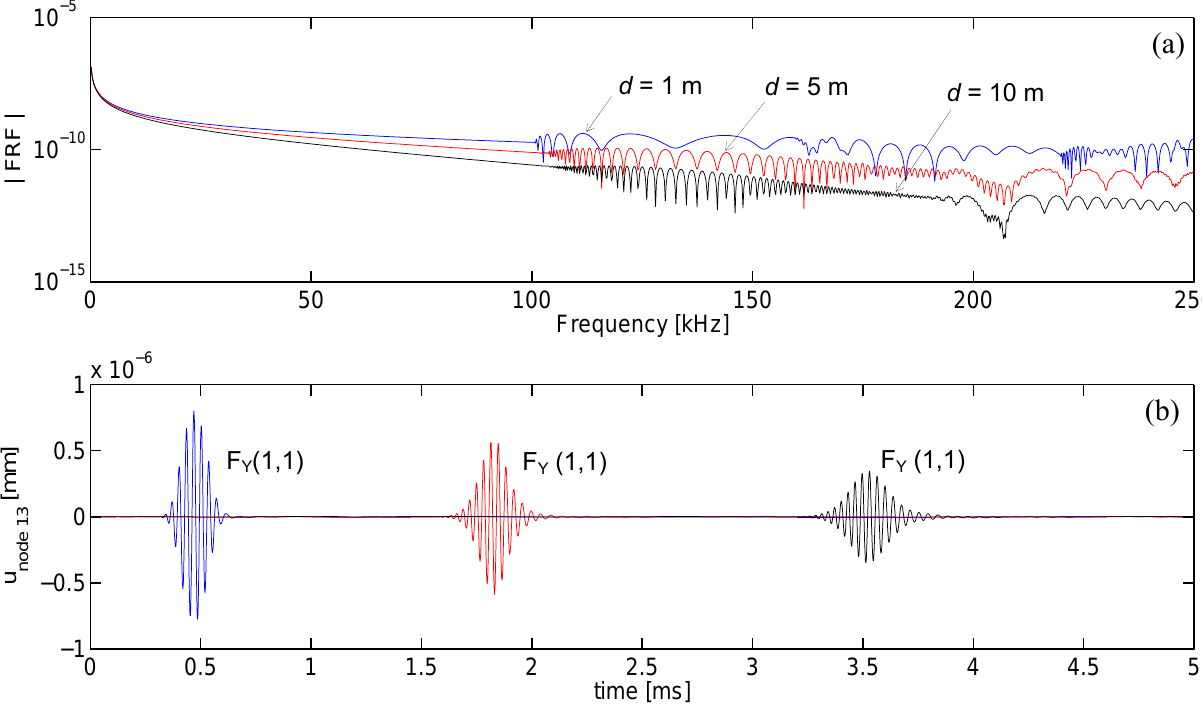
Figure 10 . Response for the x -dof of node 13 at different distances source-receiver d =z . (a) absolute value of the scaled frequency response function, (b) time-transient z S